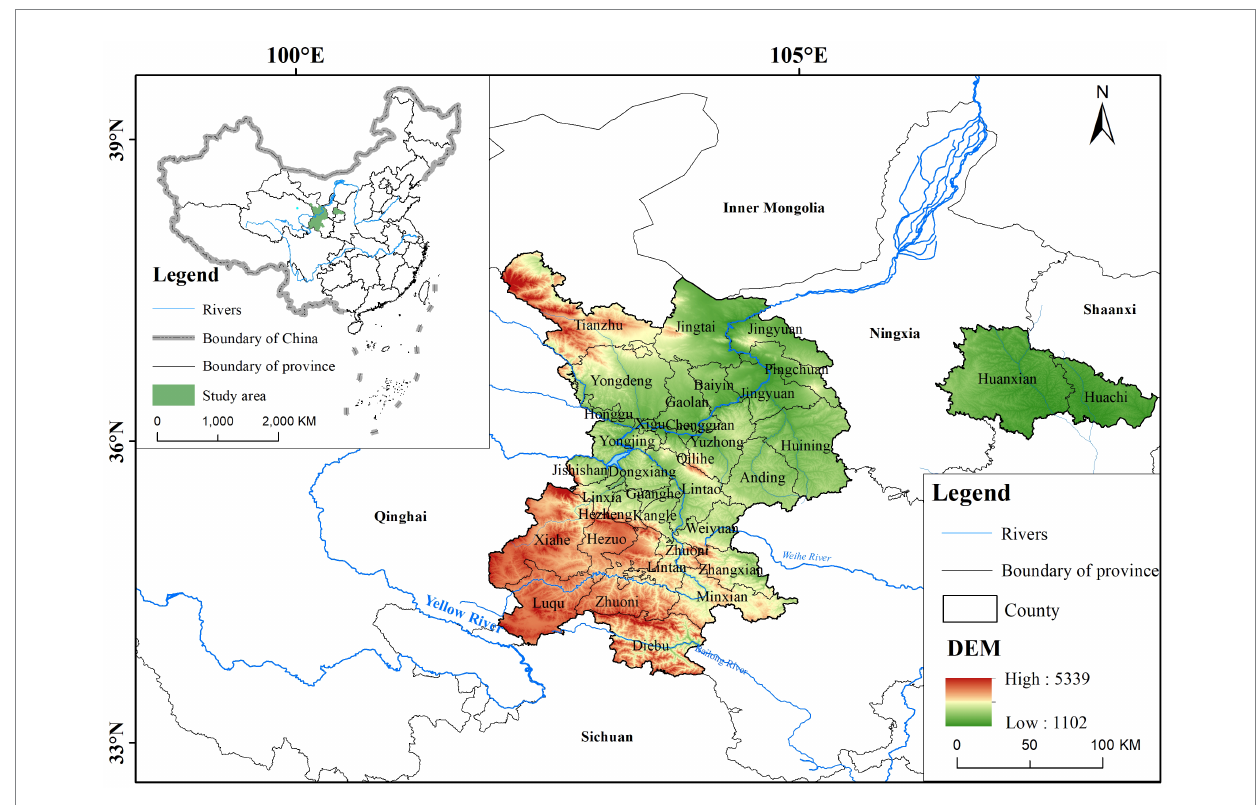
FIGURE 1 Spatial range of the study